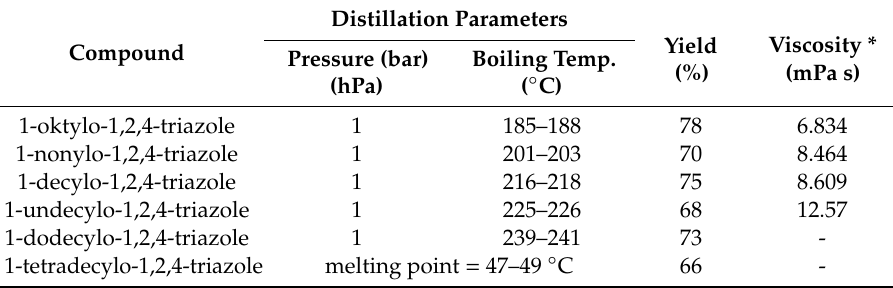
Table 1. Properties of